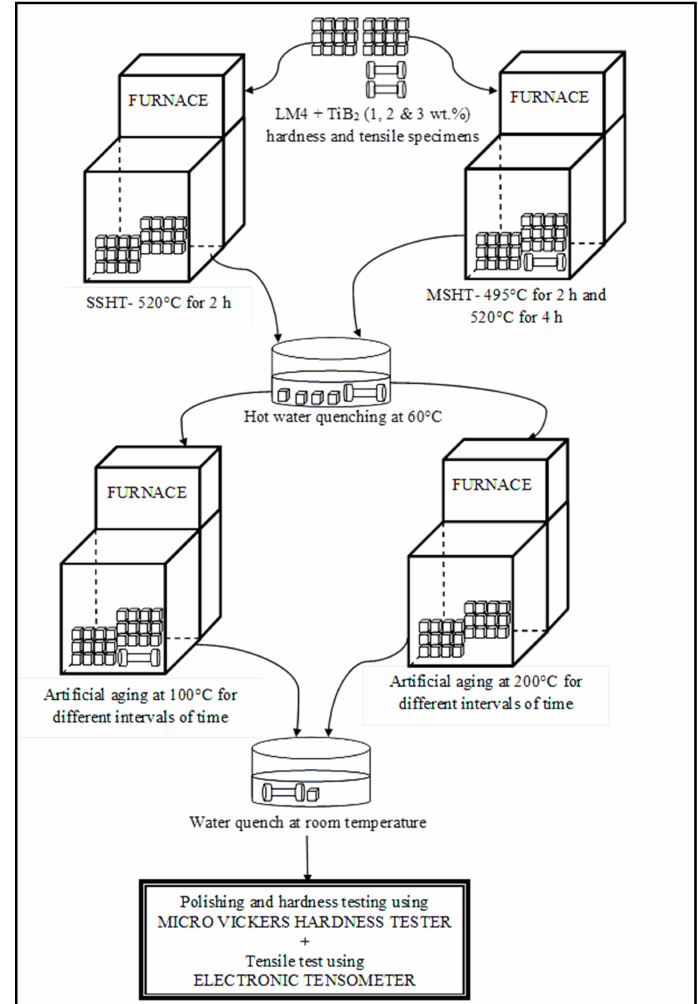
Figure 6. Process chart of precipitation hardening